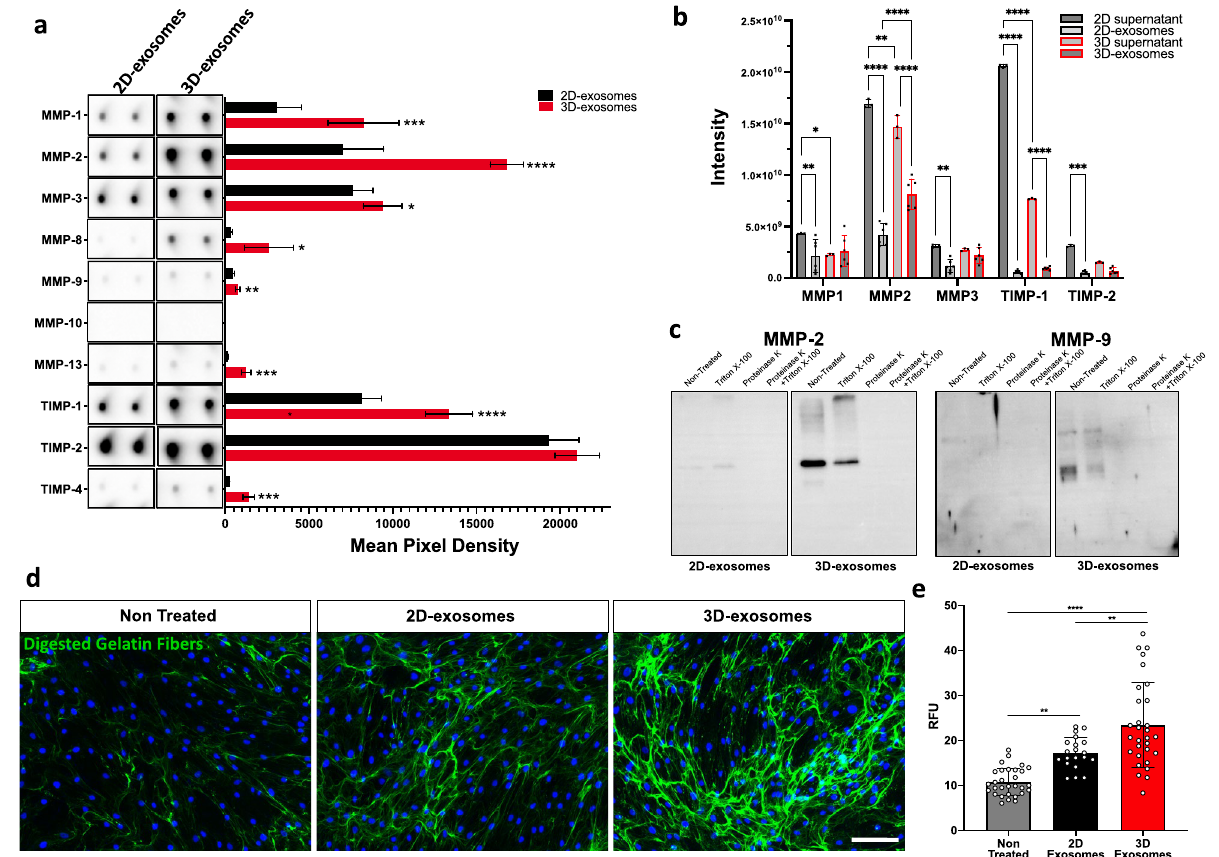
Figure 6. MMP expression profiles and enzymatic activity detected in dermal fibroblast-conditioned media. Quantification of exosomal MMPs and TIMPs using human MMP proteome profile arrays according to the culture method ( a ). An equal amount of exosomal proteins were used for each membrane. n = 3. Images of all membranes are shown in the Supplementary Fig. 8. ( b ) MMPs and TIMPs expression in exosomes and supernatant measured by MS for both cell cultures approaches ( c ) . Exosomal localization of MMP-2 and MMP-9. Equivalent amounts of all samples were resolved with SDS-PAGE and subjected to Western blotting with anti-MMP2 and anti-MMP9 antibodies. Note that the cropped images only are shown for conciseness; see supplementary figures section to see the original blots (d) . In situ gelatine zymography assay of fibroblasts treated with 2D cell culture- and 3D cell culture-derived exosomes. Nuclei were counterstained with DAPI (blue). n = 20–30. Scale bar = 50 μm. ( e ) Digested/remodelled gelatine fibers released a quencher which emits fluorescence (green). Positive fluorescence was reported as the ratio of the total area (RFU) Statistical analyses were performed by a one-way ANOVA with Tukey’s multiple comparison test. Graphs show mean ± SD. * P < 0.05, ** P < 0.01 and **** P < MMP-3, MMP-8, MMP-9 and MMP-13 expression levels were consistently found to be significantly increased in exosomes derived from dermal fibroblast grown in a 3D state (Fig. 6a and Supplementary Fig. 8). TIMP-1 and TIMP-4 expression levels were also increased in 3D-exosomes (Fig. 6a and Supplementary Fig. 8). These results were further validated by RNAseq analysis (Supplementary Fig. 9). We then crossed-referred these antibody array data with the mass spectrometry datasets focusing on exosomal and soluble MMPs and TIMPs detected in the different conditioned media. Only MMP-1, MMP-2, MMP-3, TIMP-1 and TIMP-2 were detected by nanoLC-MS/MS in the conditioned media and within exosomes (Fig. 6b). Overall, the gelatinase MMP-2 was found to be the most expressed MMPs detected in 3D-exosomes when compared to 2D-exosomes ( p < 0.0001) (Fig. 6a,b). Lower soluble MMP2 was detected in 3D-conditioned media when compared to 2D-conditioned media. In contrast, a higher exosomal MMP2 expression is detected in 3D-derived exosome, indicative of an exosomes secretion-mediated pathway. Proteinase K treatment has demonstrated that the gelatinases MMP-2 and MMP-9 are located at the external surface of the exosome’s membranes (Fig. 6c). To also measure exosomal MMP-gelatinases enzymatic activity, including both MMP-2 (gelatinase A) and MMP-9 (gelatinase B), in situ gelatine zymography was performed. In situ gelatine zymography analysis revealed a significantly improved matrix-degrading MMP proteolytic activity for both cell culture approaches (2D-exosomes: RFU of 17.20 ( p < 0.01); 3D-exosomes: RFU of 23.48 ( p < 0.0001)) in comparison to the non- treated control (RFU of 10.80) (Fig. 6d,e). These results also revealed that proteolytic activity measured in